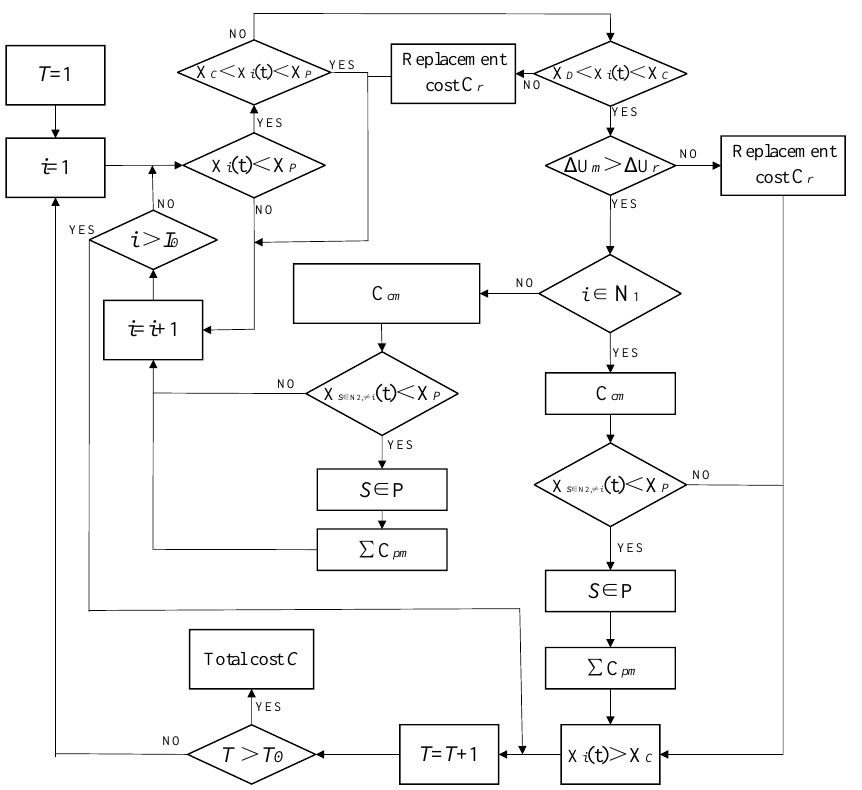
Figure 4. The grouping maintenance optimization policy.